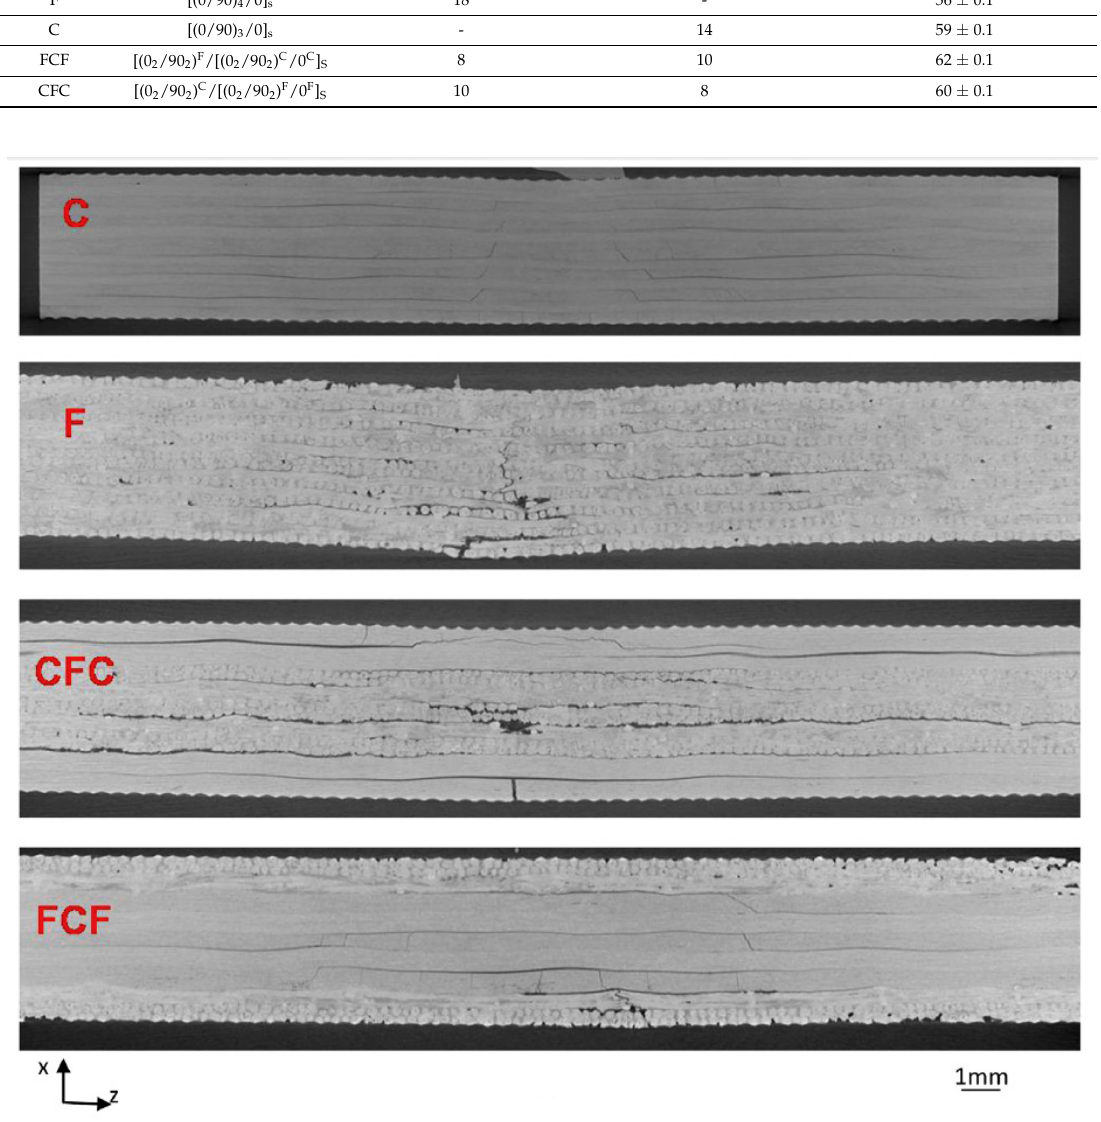
Figure 11. The computed tomography of different flax, carbon, and flax/carbon hybrid laminates impacted at 10 Joules [36] (Reproduction permission obtained).